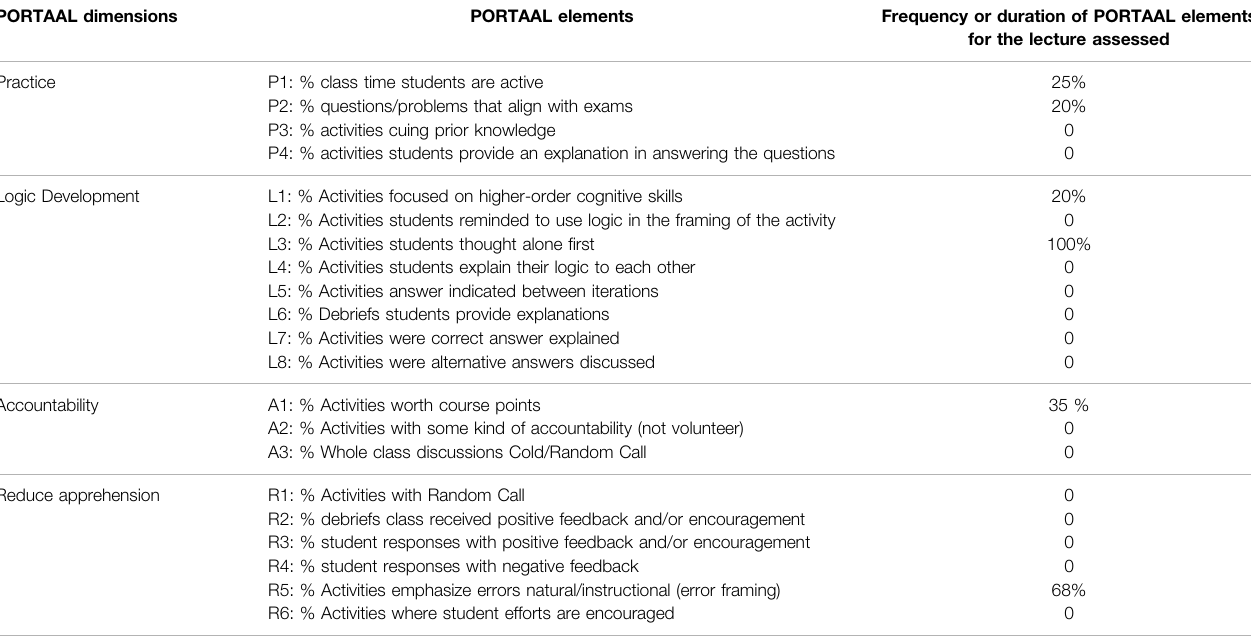
TABLE 3 | The PORTAAL assessment outcome for a single